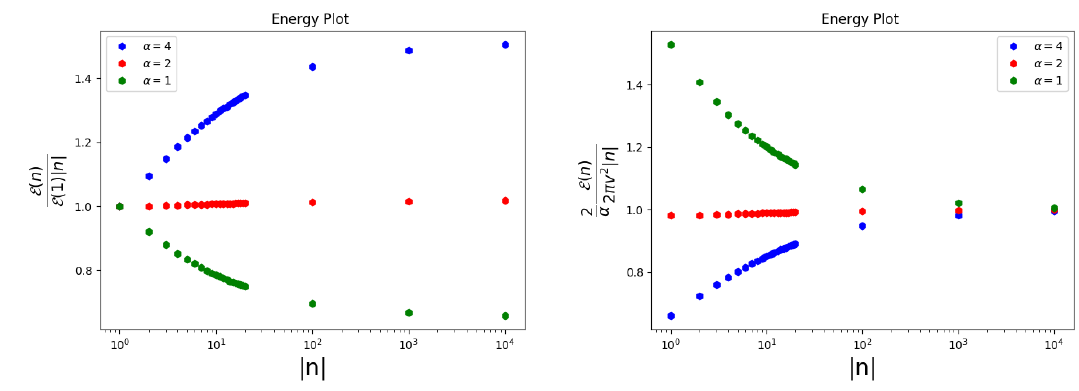
Figure 5 . Left: this shows that (cid:11) < 2 vortices are type I (attractive), separated from type II (repulsive) solutions for (cid:11) > 2 by the (cid:11) = 2 line where the solutions have vanishing interaction energy. Right: the (cid:11) -dependence of the n -vortex mass formula agrees with analytical arguments at large j n j .